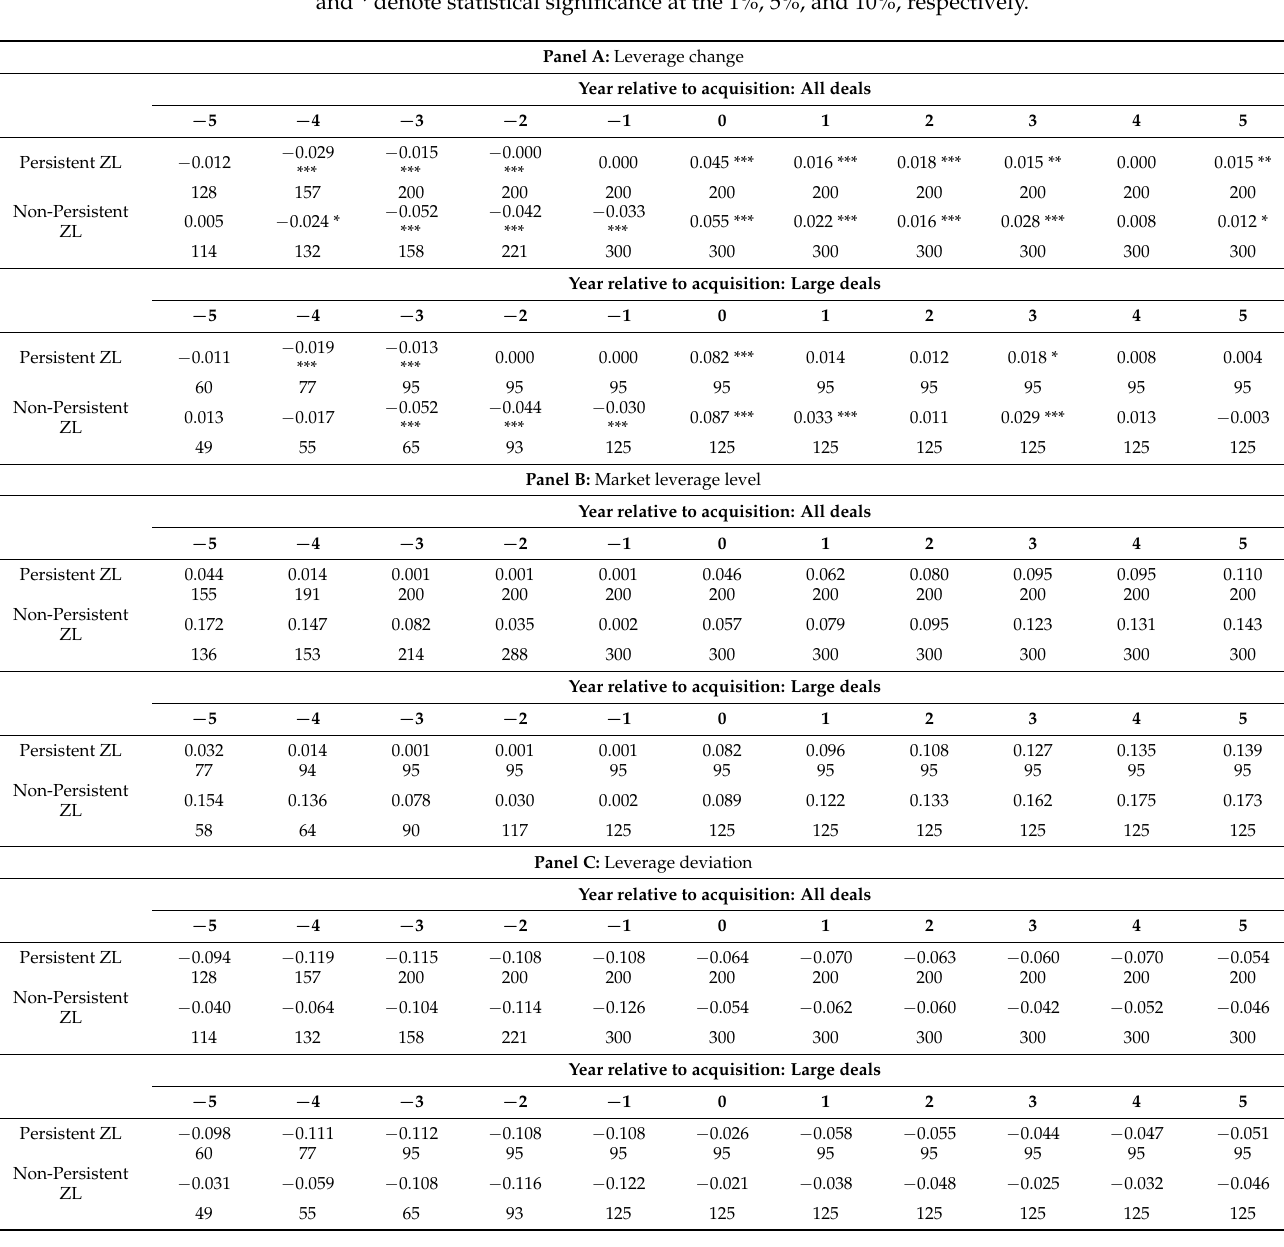
Table 8. Leverage dynamics around acquisitions by ZL acquirer. Panels A, B, and C report the average leverage change (as compared to the previous year level), market leverage level, and leverage deviation around acquisition year, respectively. Results are only presented for acquisitions in which the acquiring firm remains in Compustat from years − 1 to +5 around the acquisition year, where year 0 is the fiscal year that includes the announcement date of acquisition. Large deals are defined as acquisition deals whose relative size of the market value of the target’s assets to the acquirer’s assets is at least 20%. Panel A shows two-sided test that leverage change is zero, and the symbols ***, **, and * denote statistical significance at the 1%, 5%, and 10%,